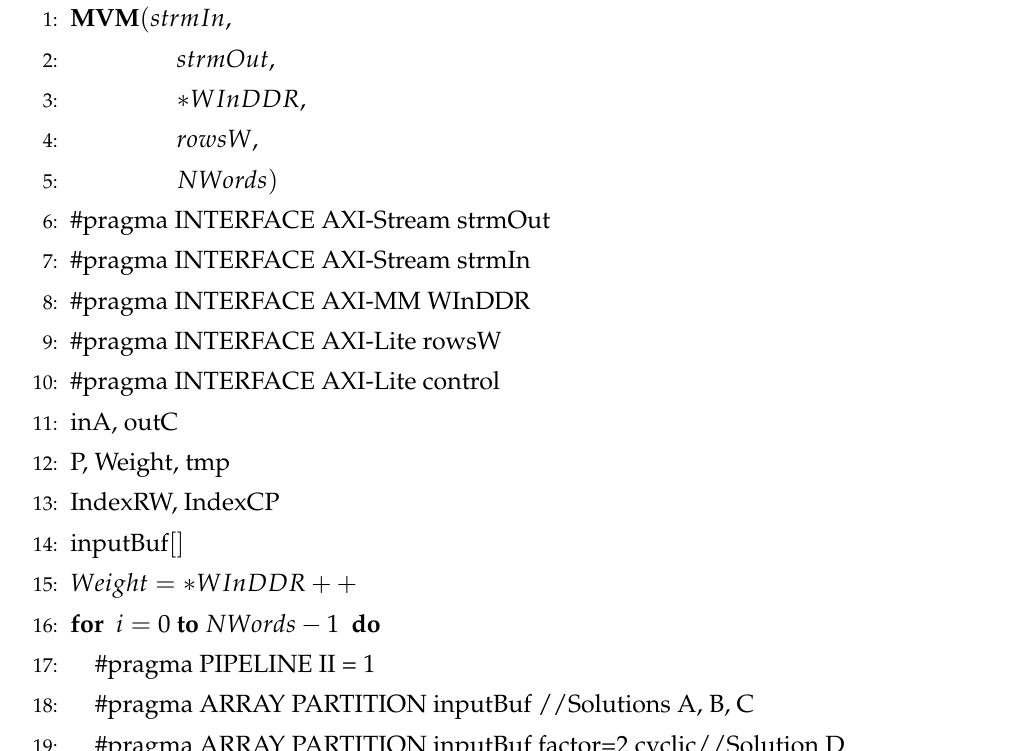
Algorithm 2 Multiplication Vector